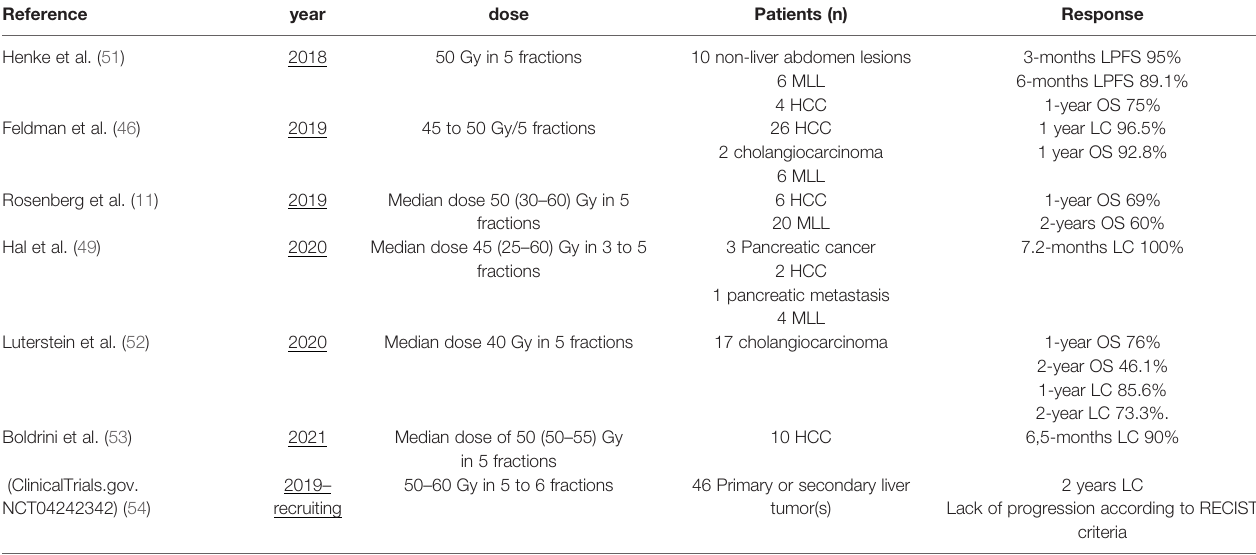
TABLE 1 | Recent clinical studies on the role of MRgRT in hepatic